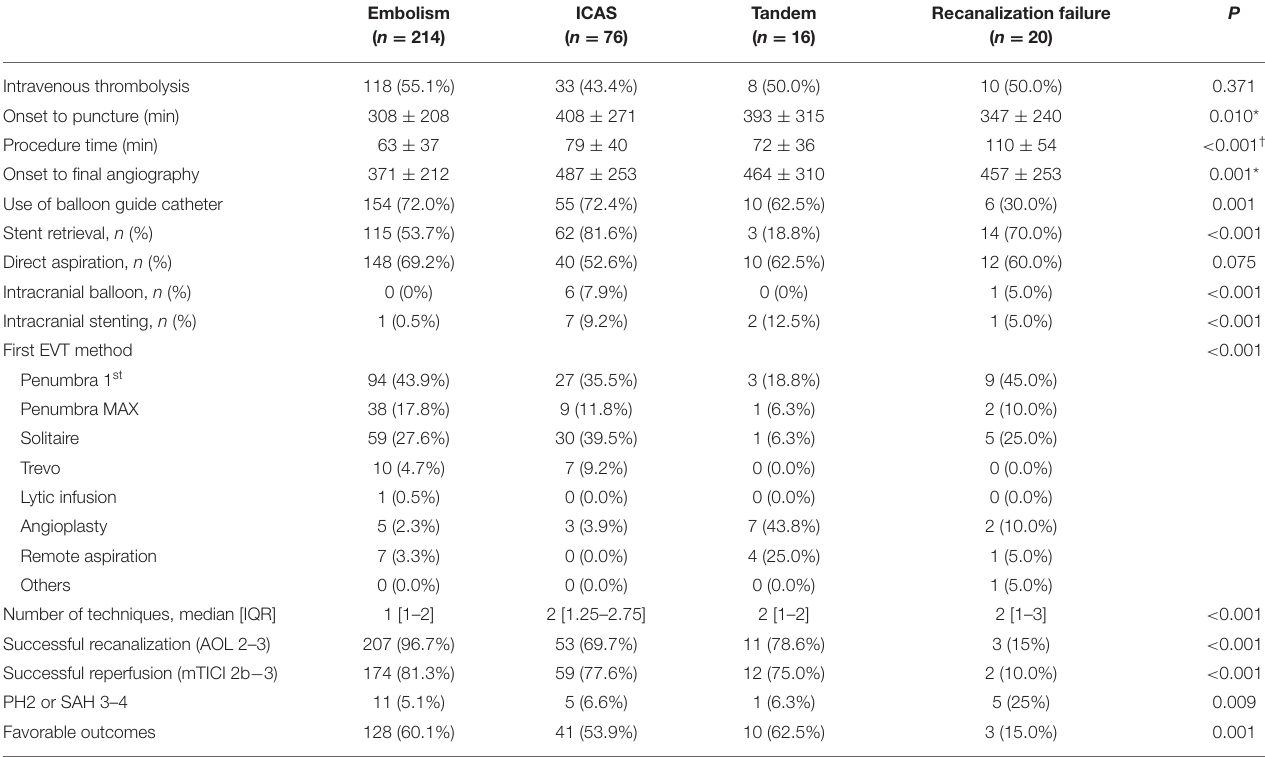
TABLE 2 | Treatment and outcomes according to the four etiologic